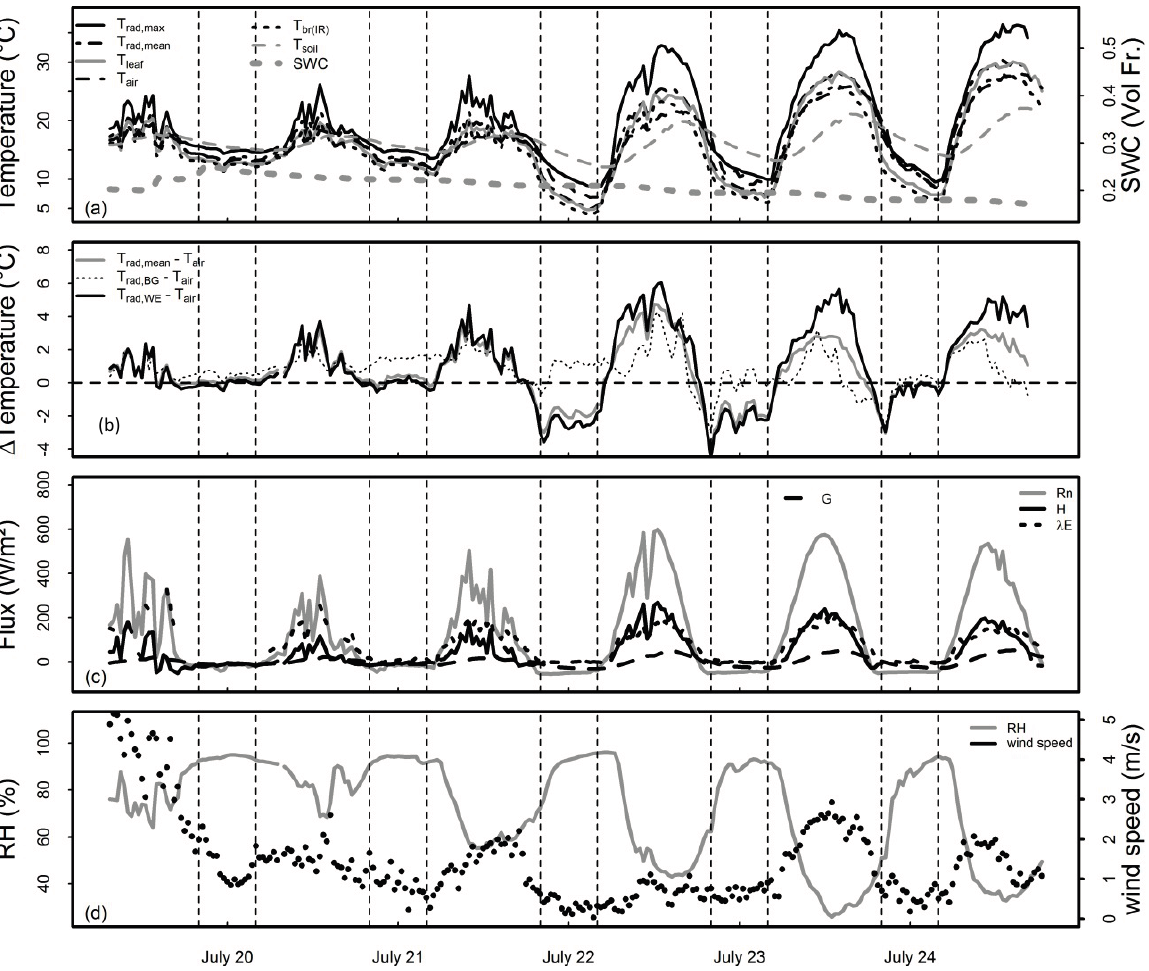
Figure 2. ( a ) Remotely sensed surface temperature by thermal imaging ( T , °C): T = average surface T ; T = maximum surface T ; T = averaged leaf T recorded rad,mean rad,max leaf = air T (°C); T = surface T recorded from an IR radiometer; from thermocouples; T air br(IR) T = soil T at − 0.02 m; SWC = soil water content (Vol fraction). The dashed vertical lines soil represent the timing of sunrise and sunset, respectively. ( b ) Is as in (a), but for the temperature = T of wheat ears; T = T difference ( Δ Temperature) with air temperature (°C); T rad,WE rad,BG of deeper shaded areas and underlying soil. ( c ) Net radiation ( Rn , W·m − 2 ), ground heat flux ( G , W·m − 2 ), eddy covariance (EC)-based sensible heat flux ( H , W·m − 2 ) and